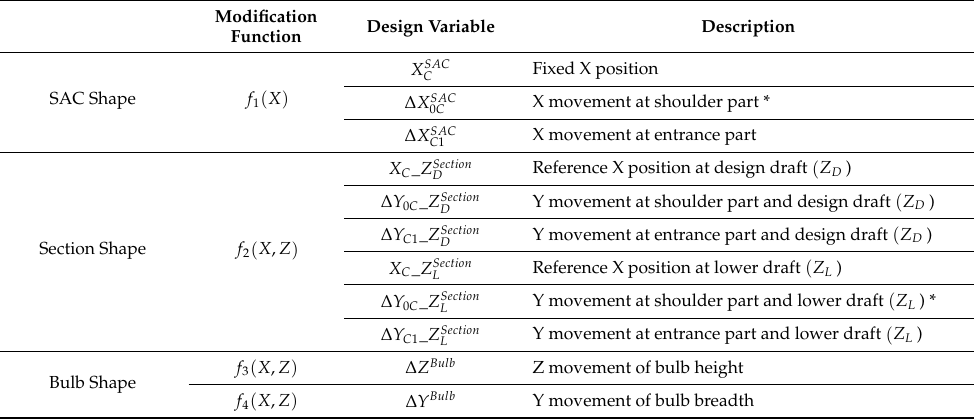
Figure 3. Relation between design variables and hull form variation. Table 2. Design variables of hull form